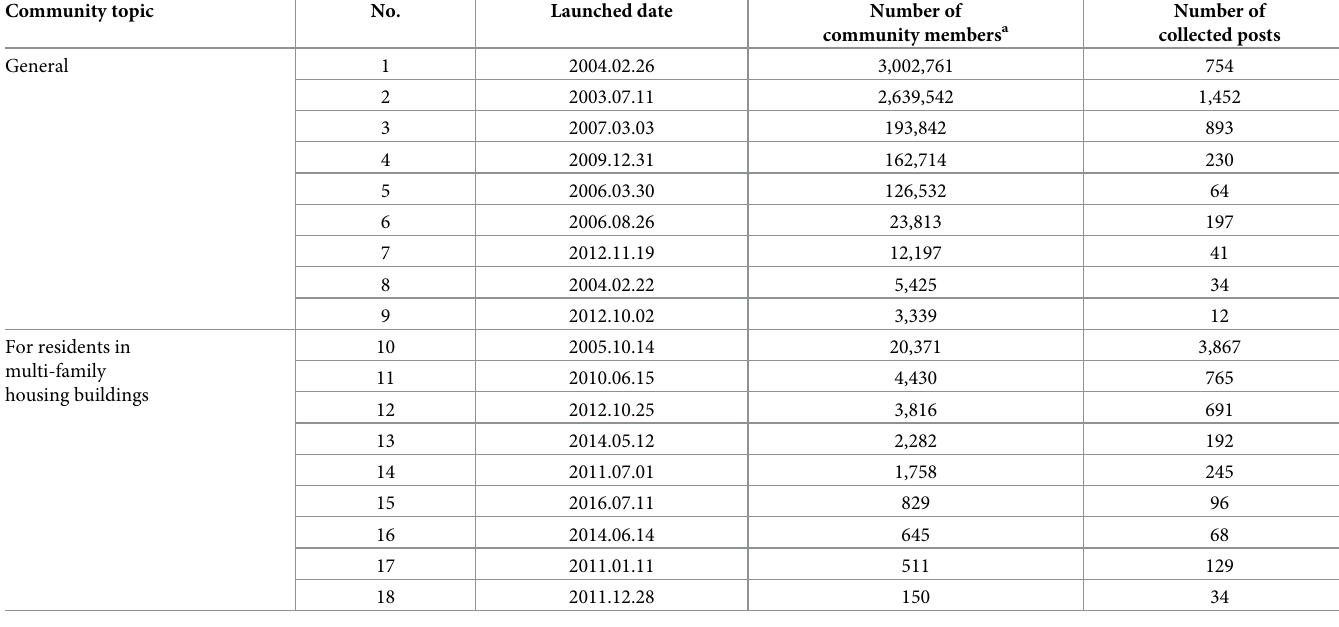
Table?1. Online communities from which emotion lexicons were collected. Community topic